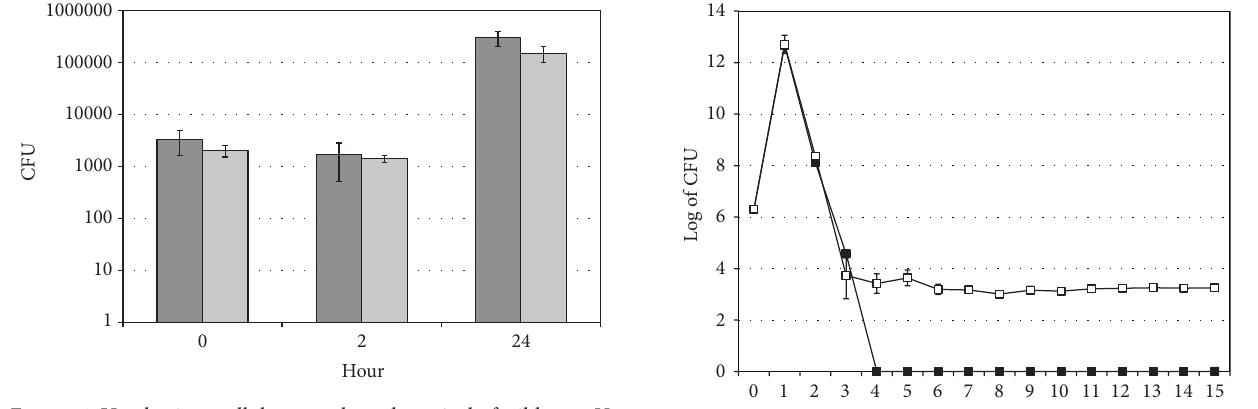
Figure 1: Uptake, intracellular growth, and survival of wild-type V. cholerae (dark grey bars) and OmpA mutant strains (light grey bars). Zero time is uptake of the bacteria by amoeba cells. Data represent mean ± SD from three different experiments.